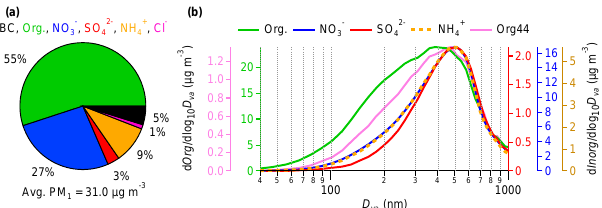
Figure 3. (a) Average compositional pie chart of PM 1 species (non- refractory PM 1 plus BC) for the whole campaign; (b) campaign- averaged size distributions for individual NR-PM 1 species where Org44 is used to represent secondary organic aerosols. The organic aerosol distribution has been smoothed using the binomial smooth algorithm within